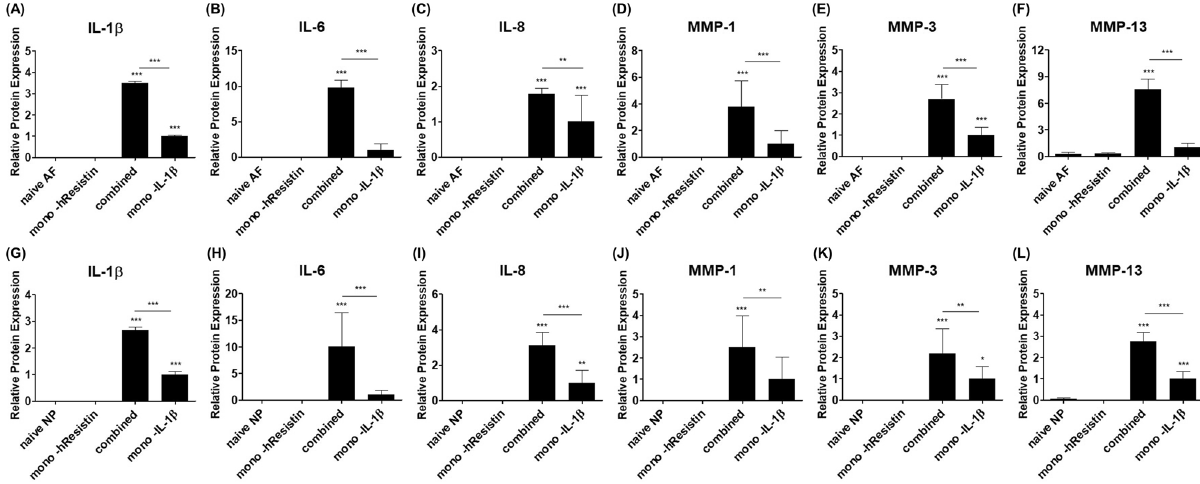
Figure 5. The change in secretion of ( A ) IL-1β, ( B ) IL-6, ( C ) IL-8, ( D ) MMP-1, ( E ) MMP-3, and ( F ) MMP-13 induced by hAF and hNP cells stimulated with mono-hResistin, combined-hResistin and IL-1β or mono-IL-1β for 48 h with respect to that of naïve group (*p < 0.05, **p < 0.005, ***p < 0.001, n =